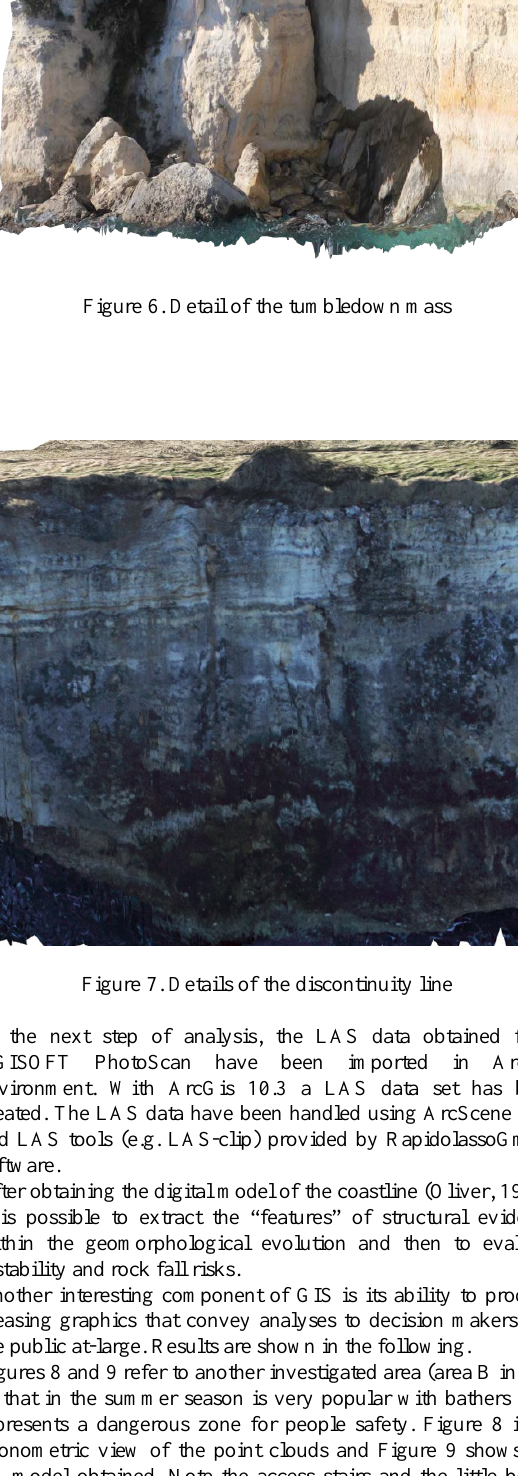
Figure 5. Orthophoto with an arched cavity